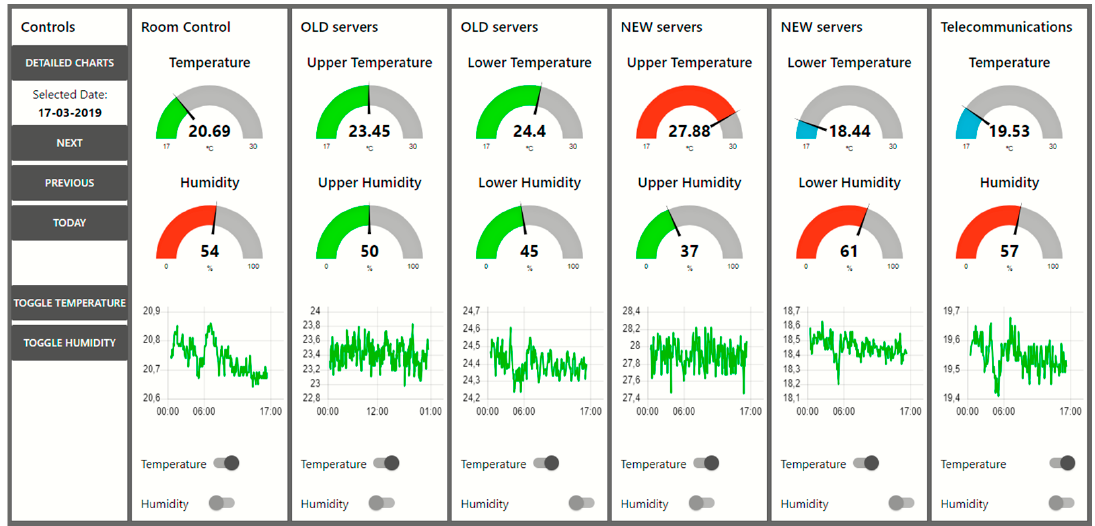
Figure 8. Query performed in the database, which indicates the last reading of each sensor.